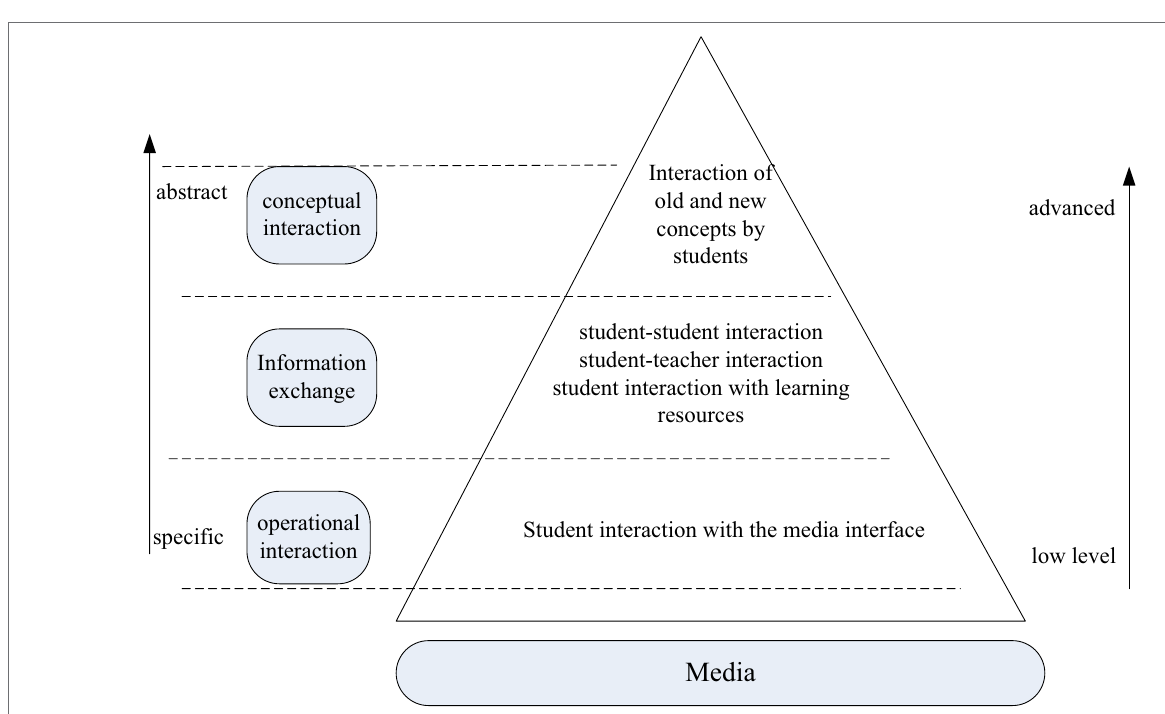
FIGURE 5 | Components of human-computer interaction and their relationships.